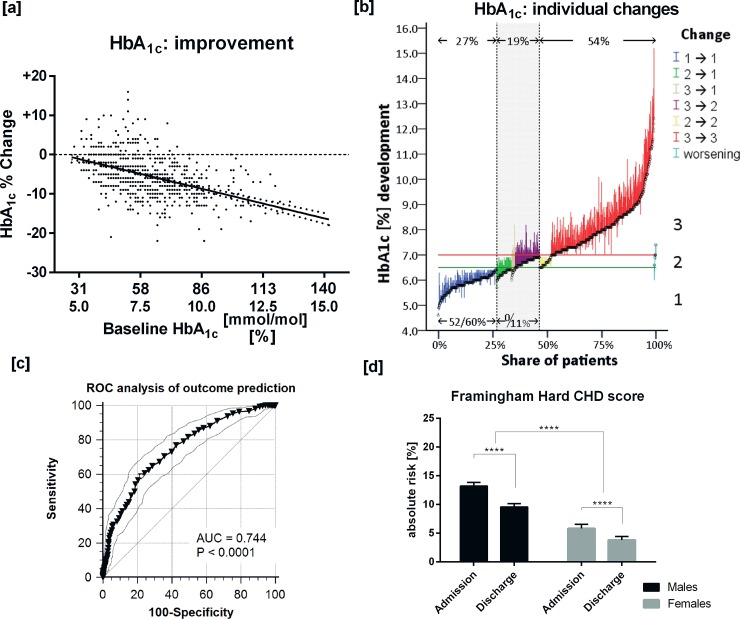
Changes in HbA1c levels (%) from baseline in response to three weeks at the DRC.[a] Dependence of relative improvement on initial HbA1c concentration; [b] individual changes in HbA1c: vertical lines denote the respective changes in HbA1c incurred at discharge (vs. at admission) by single patients with type 2 diabetes, and black circles values reached at discharge showing 27% to stay below and 8% to reach an HbA1c <6.5%, while in 11% HbA1c decreased to <7.0%, i.e. to therapeutic target. Patients between dotted vertical lines improved HbA1c by at least one category (1: <6.5; 2: 6.5 - <7.0; 3: >7.0%). Bottom: share of the respective subgroup (%) in complete remission (HbA1c <6.5% without any anti-diabetic medication) at admission vs. at discharge. [c] Prediction of HbA1c outcome (decrease > 6% of baseline values) by baseline HbA1c levels; and [d] improvement of the Framingham Hard CHD risk score (means ± 95% confidence interval; subgrouped for sex) in response to three weeks at the DRC. **** p<0.0001.